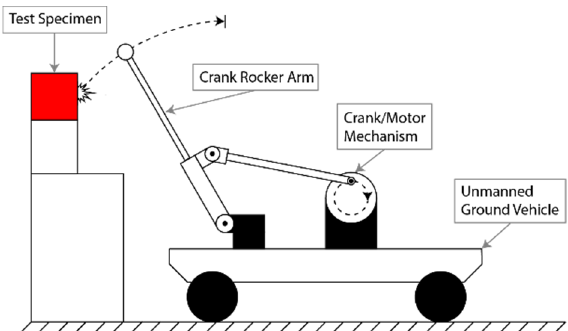
Figure 5. Experimental setup and concept drawing.